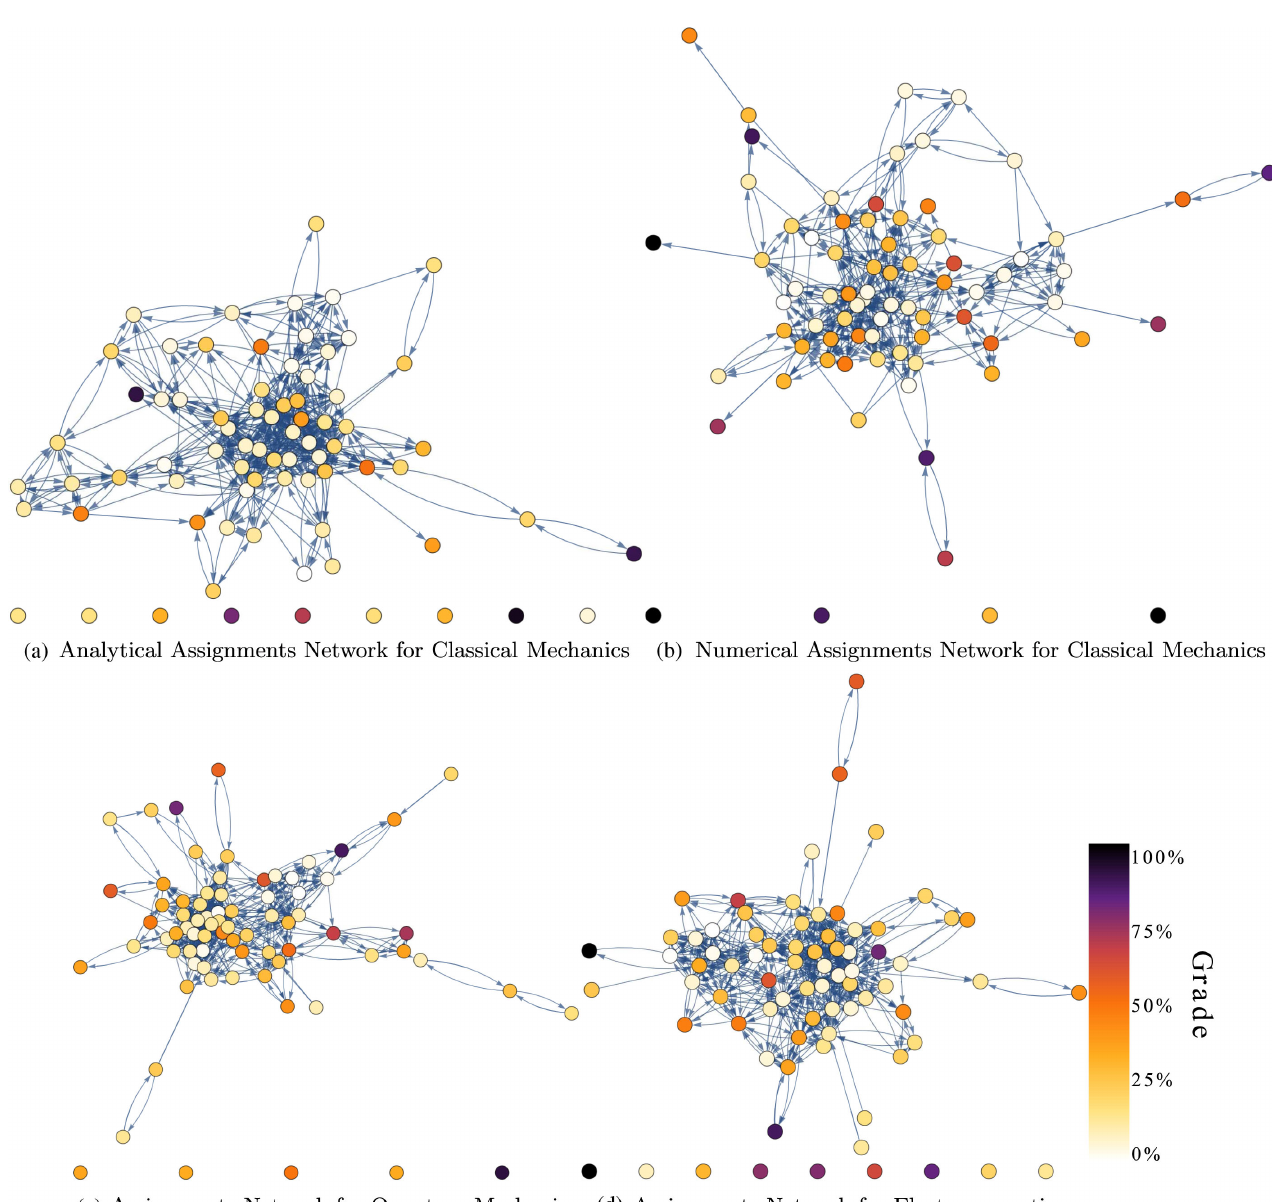
FIG. 2. Student collaboration networks for three upper level physics courses. Weighted student collaboration networks constructed from surveys given to students in three upper-division courses: Classical mechanics, quantum mechanics, and electromagnetism. Note that while these networks were generated from the weighted adjacency matrices, for ease of representation, only the direction of links is represented here. Nodes correspond to students and the direction of each arrow indicates the direction of assistance on homework assignments. The color of a node indicates the grade of a student on homework assignments. Although we do not normalize grades in our analysis we present grades as a percentage here to illustrate multiple courses